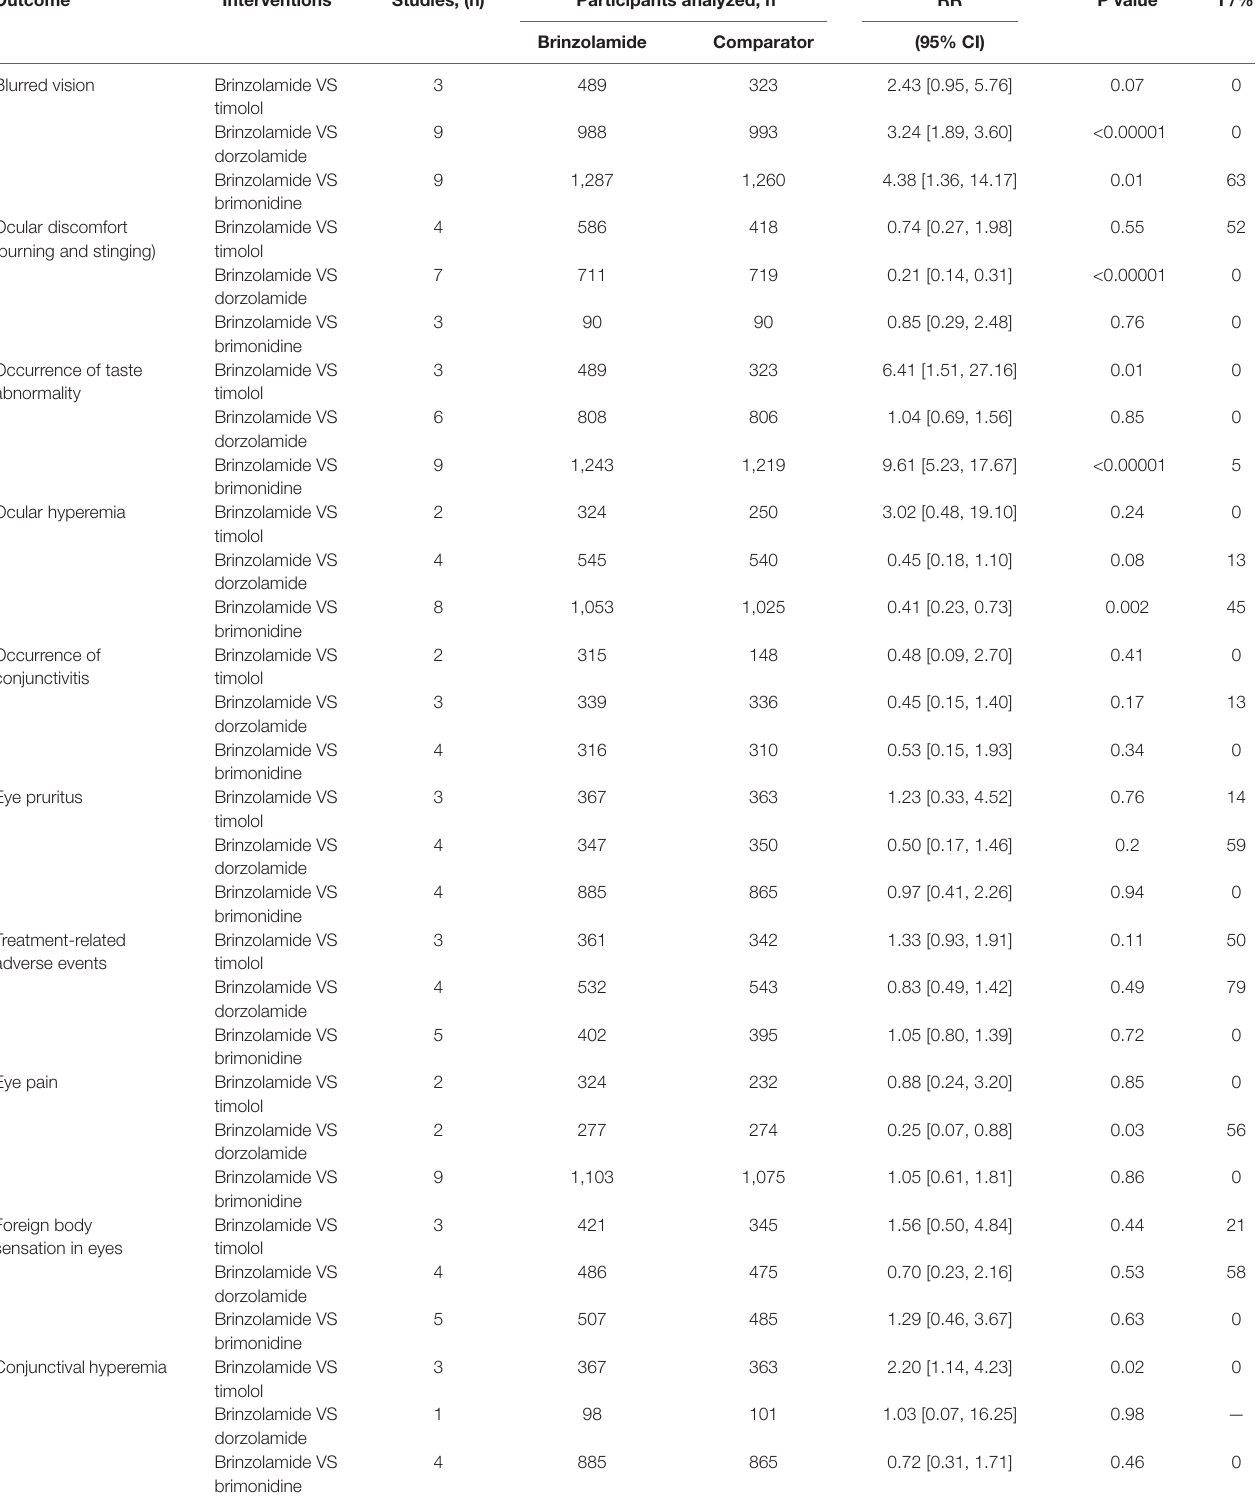
TABLE 1 | Meta-analysis for the efficacy and safety